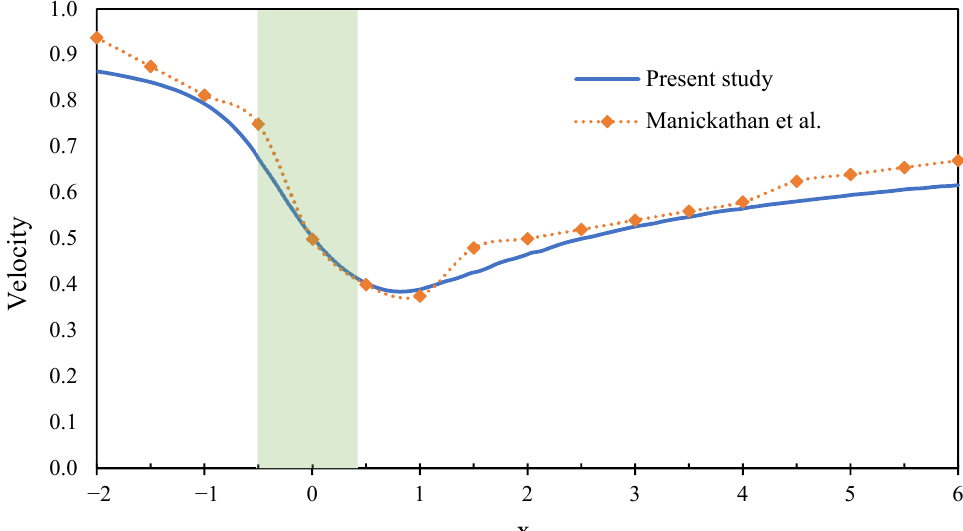
Figure 14. Comparison of wind speed on the analysis line, in addition to the vegetation zone under the indication of the green patch in the range of − 0.5 to 0.5 on the x -axis. (Reprinted with permission from [29]. Copyright 2019 Mohammadi Murtaza and John Kaiser Calautit.).